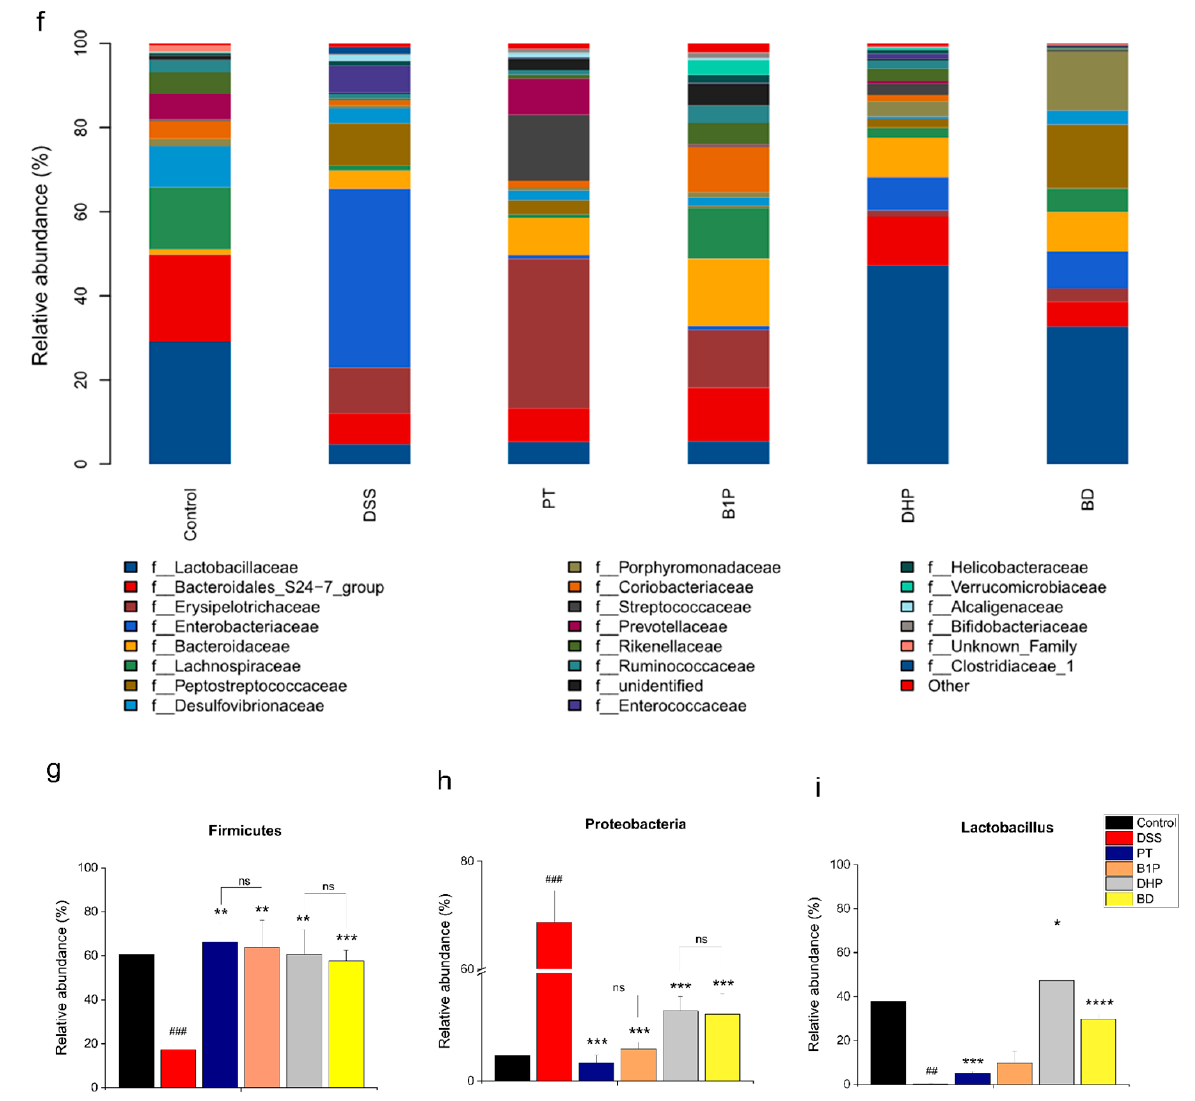
Figure 5. 16S rRNA gene sequencing analysis of gut microbiota regulated by PT, DHP, the combination of BBR with PT, and DHP. ( a ) Rarefaction curves. ( b ) Shannon index showed the α – diversity of the microbial community. ( c ) PLS–DA showed the β –diversity of gut microbiota. ( d ) Heatmap showed the changes in relative abundance of microbial compositional profiling at the genus level. ( e ) Cladogram exhibited the difference in richness and the group with a significant difference in abundance. ( f ) Community histogram showed the compositional discrepancy between various groups at family level. ( g – i ) Relative abundance of Firmicutes, Proteobacteria, and Lactobacillus. The t –test was utilized for statistical analysis. ns, not significant, ## p < 0.01, ### p < 0.001, compared with the control group; * p < 0.05, ** p < 0.01, *** p < 0.001, **** p < 0.0001, compared with the DSS group.